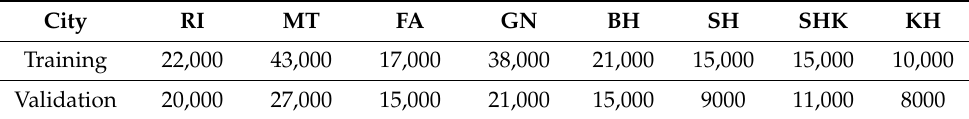
Table 6. Total number of training and validation samples for land cover map classification and accuracy